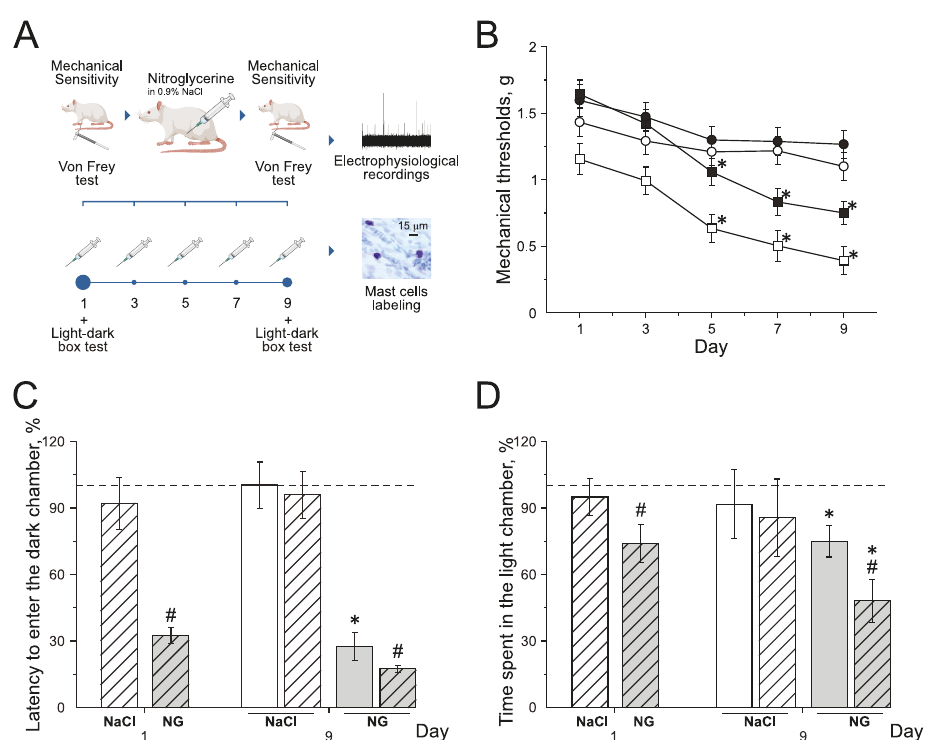
Figure 1. Effect of chronic nitroglycerin (NG) administration on mechanical sensitivity and photopho- bia. ( A ) Experimental scheme. ( B ) Mechanical withdrawal thresholds of rats before and two hours after the administration of NG (black and white squares) or vehicle (NaCl) (black and white circles). ( C ) Latency to enter the dark chamber and ( D ) time spent in the light chamber before (open columns) and two hours after (dashed columns) the administration of vehicle (white columns) or NG (grey columns) on the 1st and 9th day (in %) compared to the initial values taken as 100% and marked with a dotted line. * p < 0.05 compared to 100%; # p < 0.05 compared to the pre-injection